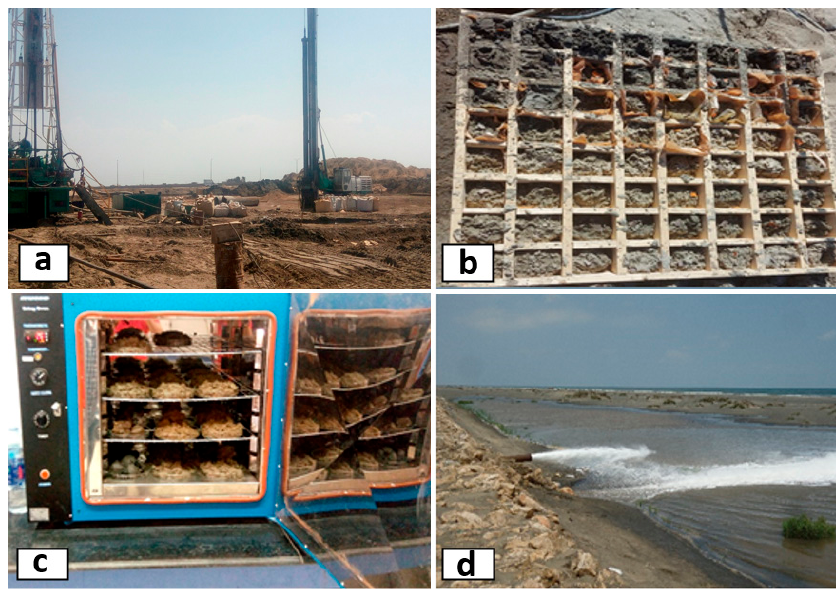
Figure 5. ( a ) Drilling of wells in the study area, ( b ) sediment samples during drilling of wells, ( c ) drying the sediment sample in the oven, and ( d ) during the pumping test of well.